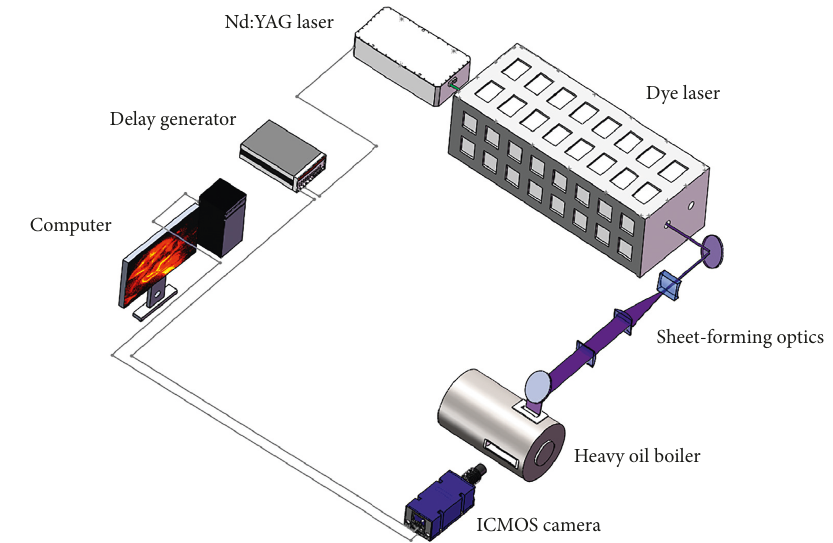
Figure 1: Experimental setup schematic Table 1: Oxy-fuel experimental conditions.